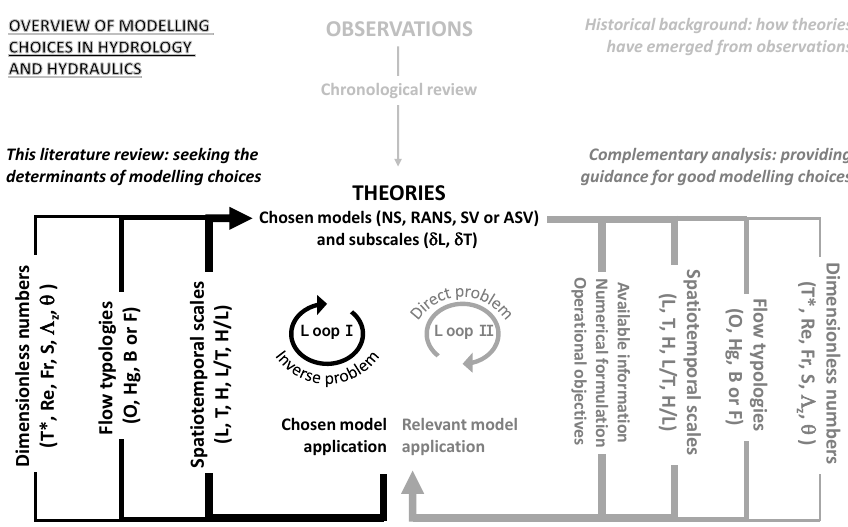
Figure 11. This figure provides a simplified overview of the available modelling choices in hydrology, in three distinct colours associated with specific research purposes or disciplines, showing the position of the present review relative to the others. The pale grey section aims at understanding how the available flow models have emerged from observations and early formulations of the flow equations, focusing on their conditions of validity, i.e. the successive hypotheses made during their derivation. The black section recalls the procedure followed in this review paper (Loop I, “inverse problem”). Literature sources are processed through a procedure that analyses how the spatiotemporal scales (spatial scale L , timescale T , flow depth H , L/T and H/L ratios), and then flow typology (Overland O, High-gradient Hg, Bedforms B, or Fluvial F) and dimensionless numbers (dimensionless period T ∗ , Reynolds number Re , Froude number Fr , bed slope S , inundation ratio (cid:51) z , Shields parameter θ ) determine the choice of a flow model (Navier–Stokes NS, Reynolds-averaged Navier–Stokes RANS, Saint-Venant SV, or approximations to Saint-Venant ASV) and that of data collection and/or modelling subscales ( δL , δT ). Suggested in medium grey on the right are the scope and principles of future research challenges that would address the what should be done? (Loop II, “direct problem”) question in reply to the current what has been done? concern (Loop I). A full picture would be assembled when also reviewing the historical background, that is how theories have emerged from observations